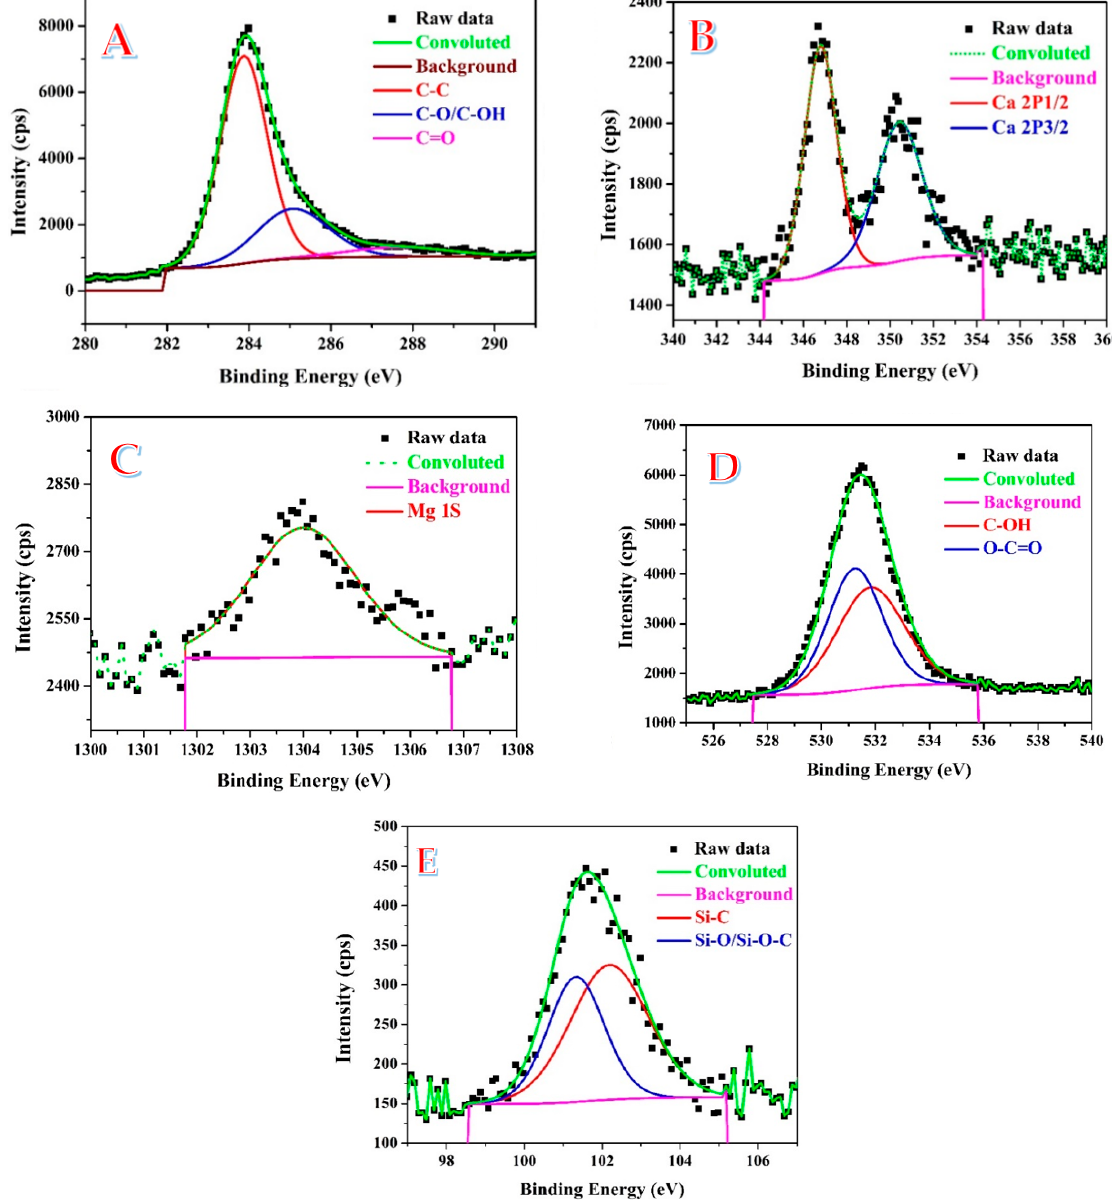
Figure 8. X-ray photoelectron emission spectroscopy of the C1s: ( A ), Ca2P; ( B ), Mg1S; ( C ), O1s; ( D ) and Si 2p; ( E ) core levels spectra for a powder produced from hydrothermal treatment using 1.0 M KOH at 170 °C for 3 h and calcined at 600 °C.